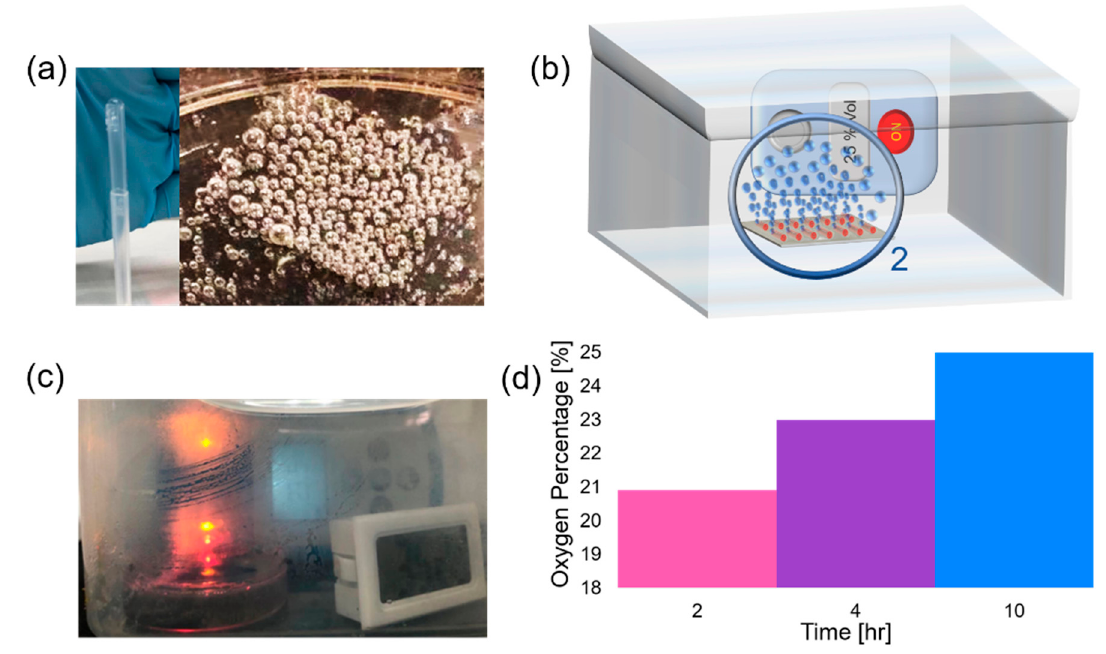
Figure 6. ( a ) Oxygen bubbles generation from silicon sample containing rolled-up Ti / Cr / Pd microtubes in 10% SDS and 1.5% v / v H 2 O 2 ; ( b ) schematic image of oxygen bubble generator in a closed volume of space filled with air; ( c ) optical image of oxygen bubble generator prototype with humidified water condensed on the glass; ( d ) percentage of oxygen concentrations in the open air (pink region), large (purple region) and small (blue region) boxes with a hermetic seal.